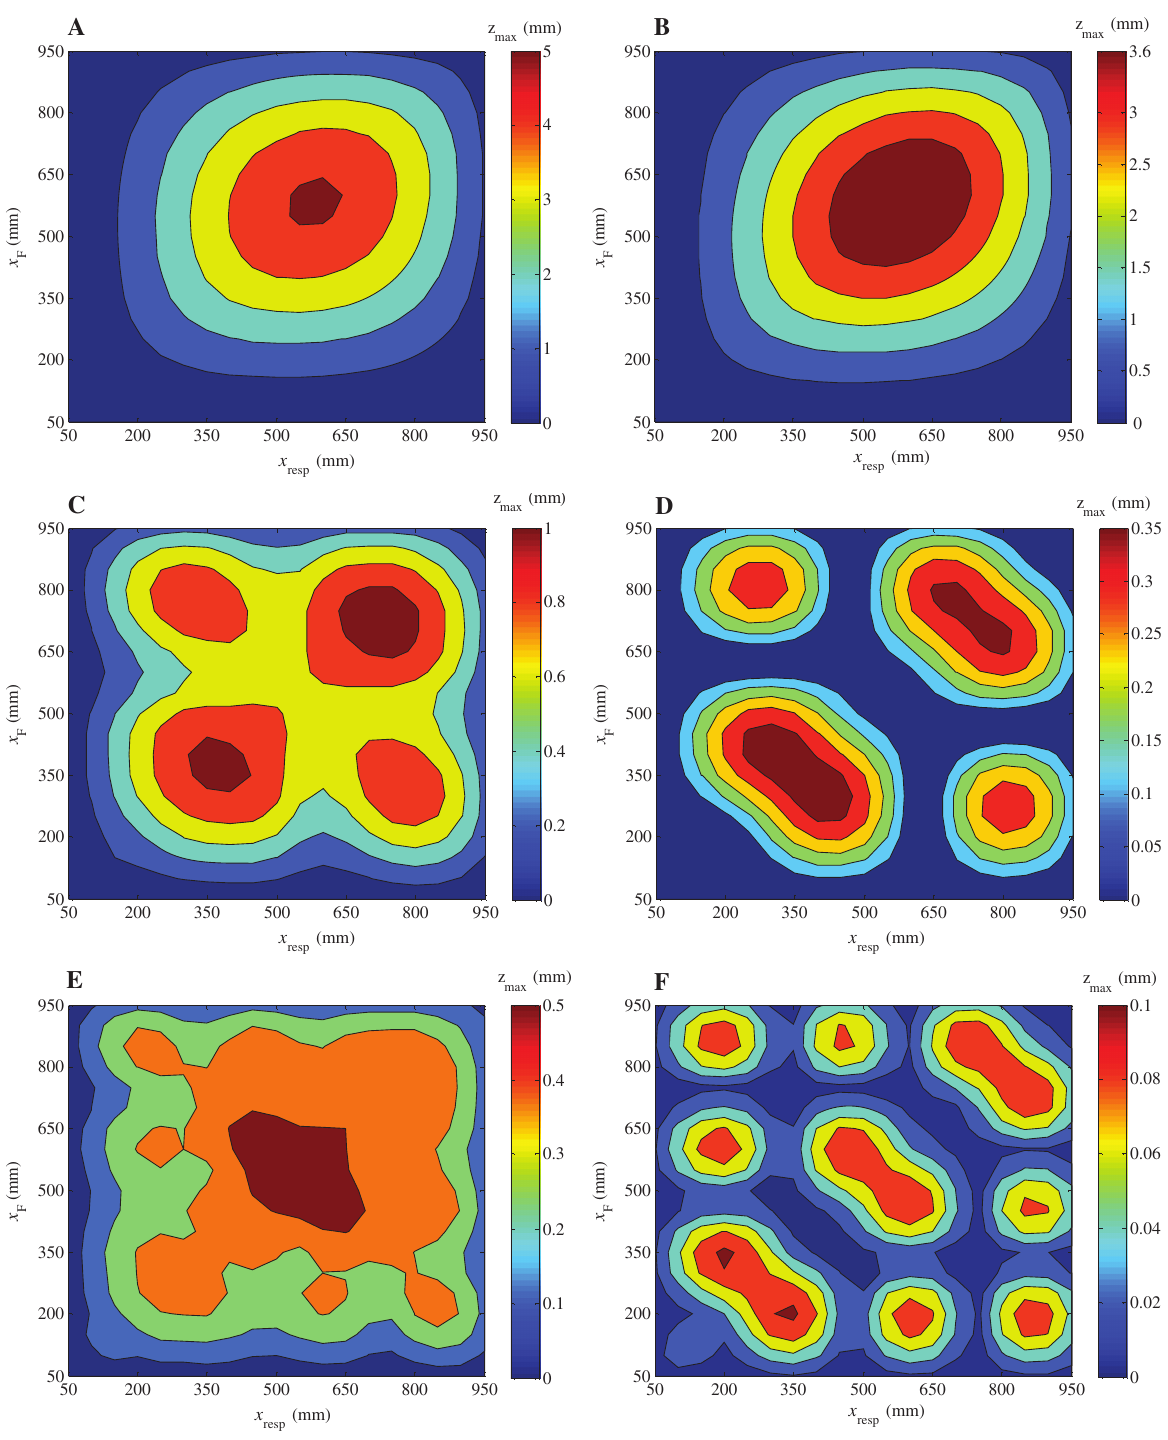
lay-up (A) 5 Hz, ζ = 0.0, (B) 5 Hz, ζ = 0.02, (C) 50 Hz, s